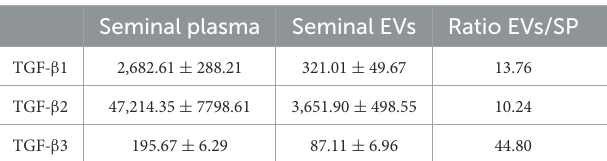
TABLE 2 Concentrations (pg/mL; mean ± SEM) of transforming growth factor (TGF) - β 1, - β 2 and - β 3 in samples of seminal plasma (SP) and isolated seminal extracellular vesicles (EVs) of healthy breeding male pigs used in commercial artificial insemination programs ( n = 8, each sample pooled 10 individual SP